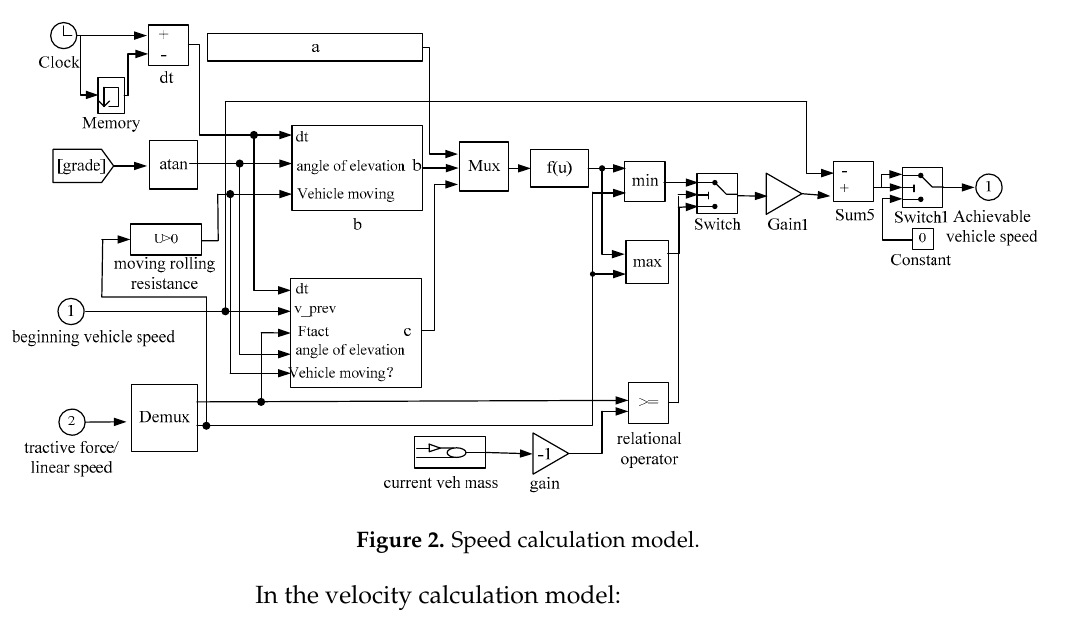
Figure 2. Speed calculation model.